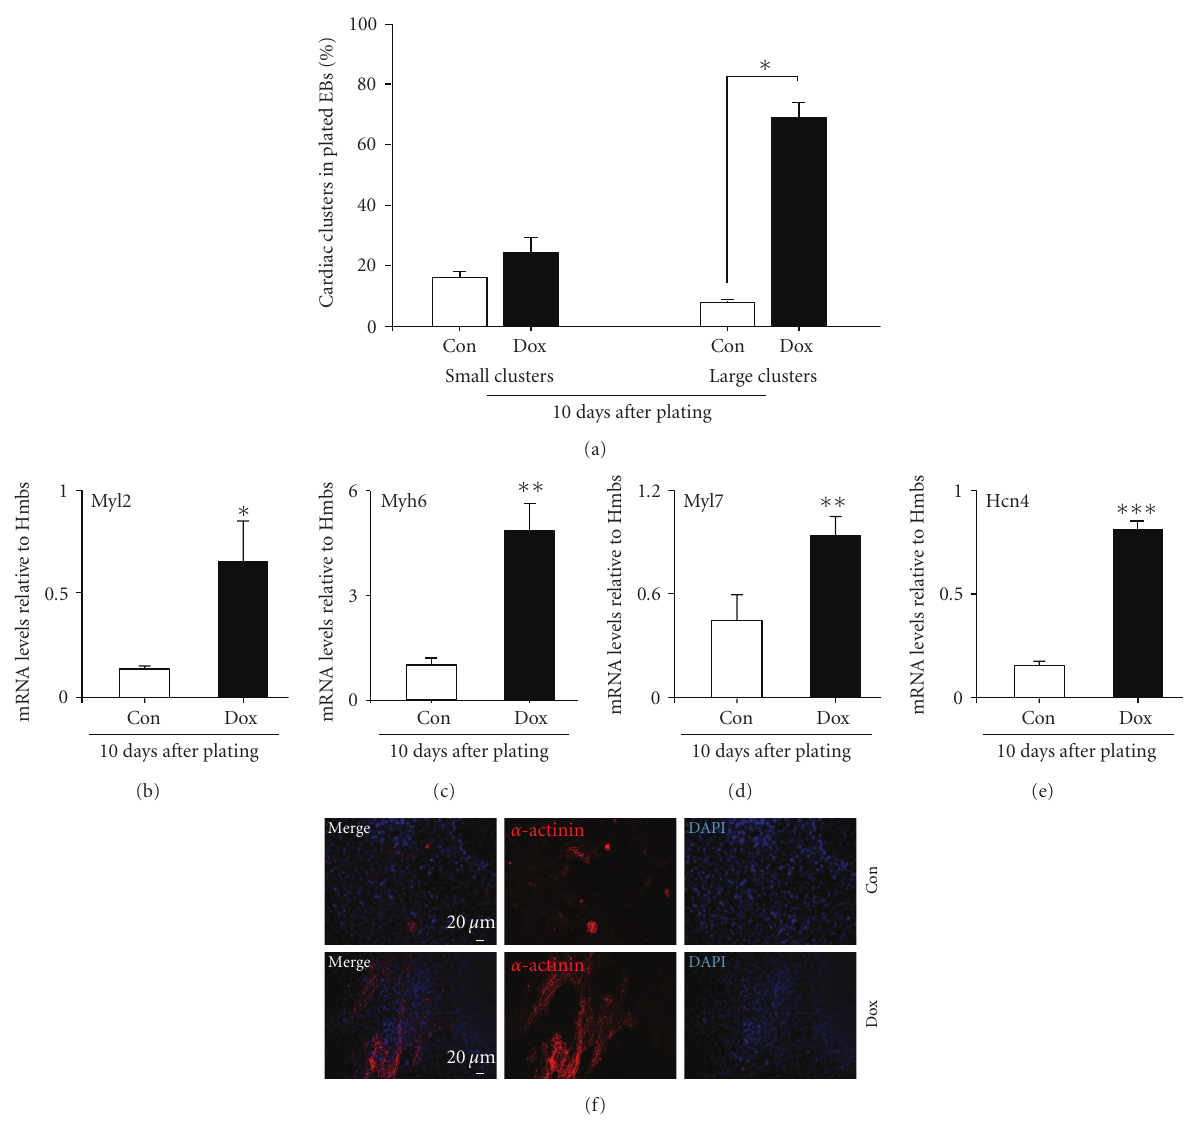
Figure 5: Cardiac di ff erentiation is increased upon doxycycline treatment. (a) The number and size of cardiac clusters arising in dox-treated and untreated cultures were evaluated and counted. Dox treatment leads to a strong increase in both number and size of spontaneously beating cell clusters 10 days after plating. Small clusters: < 100 μ M; big clusters > 100 μ M. (b–e) Expression of cardiac marker genes upon induction of SK4. On mRNA level, the cardiac specific transcripts Myh2 (b), Myh6 (c), Myl7 (d), and Hcn4 (e) are significantly elevated upon dox treatment ( n = 4). (f) This is also evident in immunocytochemical stainings using cardiac specific antibodies directed against α - actinin (red). The size of cardiac clusters is highly increased 10 days after plating. Nuclei are stained by DAPI (blue). Scale bars as